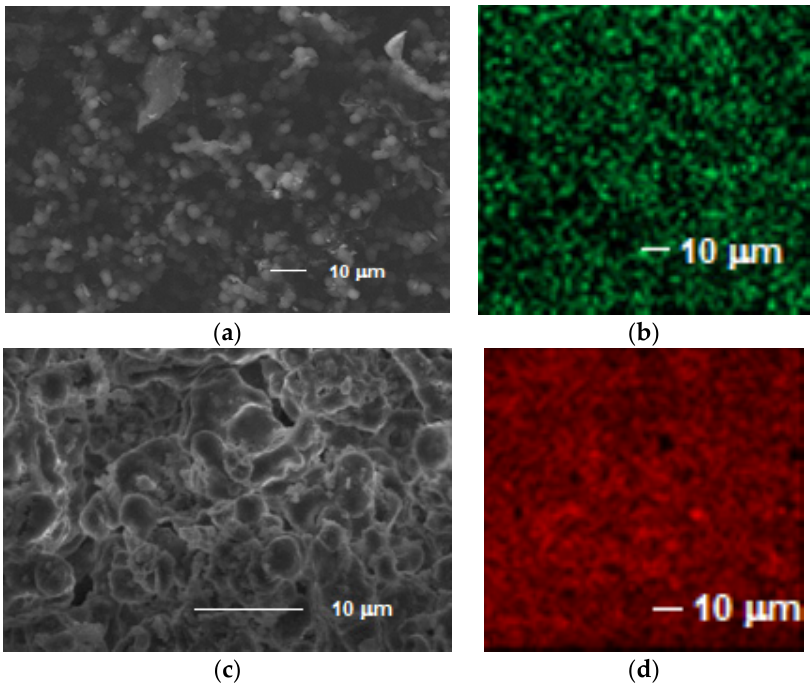
Figure 7. ( a ) SEM image and ( b ) Pd elemental mapping of Pd catalyzed AM4-HDA porous poly- mer I-10w-60d in sc-CO 2 , catalyzation time: 2 h, ( c ) SEM image and ( d ) Ni elemental mapping of AM4-HDA porous polymer after Ni plating in sc-CO 2 , plating time: 30 min.